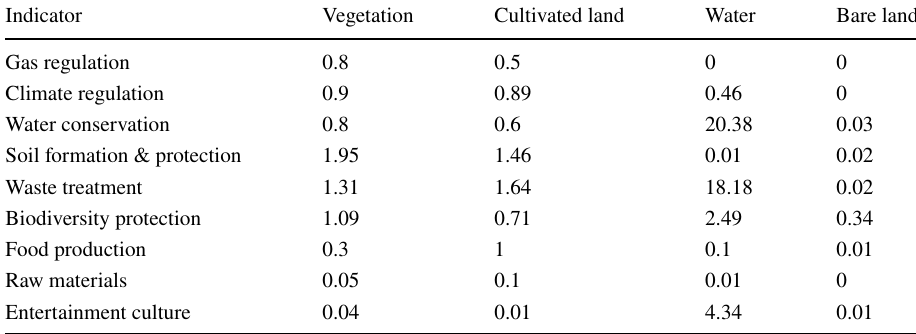
Table 2 China terrestrial ecosystem unit area ecological service value equivalents